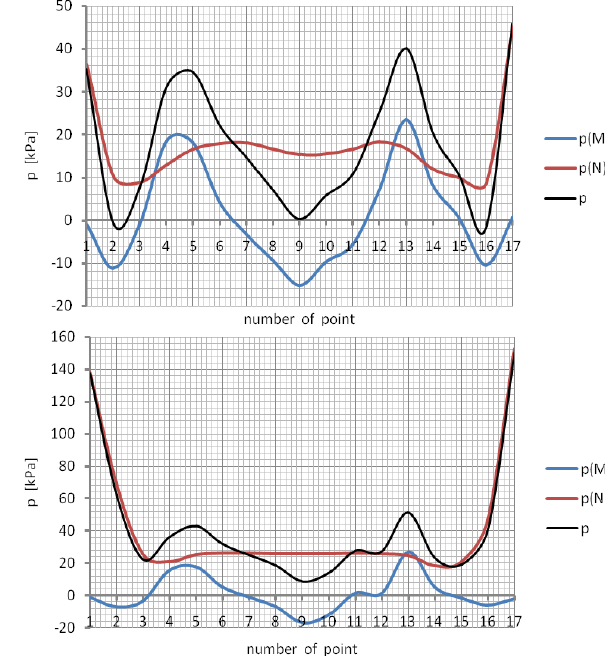
Figure 7: Comparison of the impact of bending and axial forces on soil